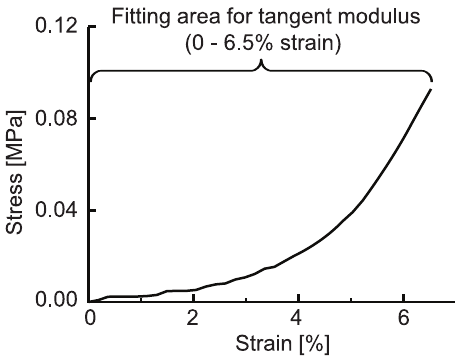
Figure 5. An example of stress-strain curve. The region from 0% to 6.5% strain was fitted by an analytic curve to obtain a tangent modulus.